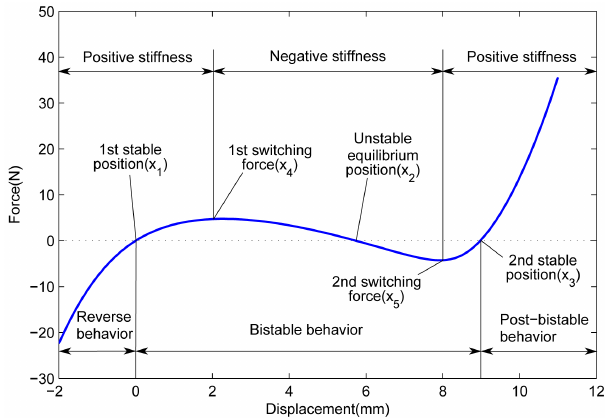
Figure 2. The complete kinetostatic behavior curve of a bistable